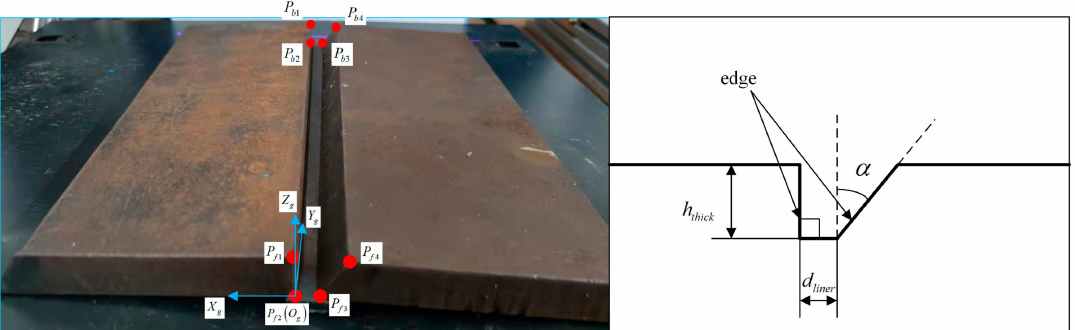
Figure 10. Characteristics points and parameters of the test steel plate. As for the selected groove, the thickness of the test steel-plate is represented by h thick , and the width of the button face is represented by d liner ; the left edge is vertical, and the right edge forms an angle of α degrees. h thick is 20 mm, d liner is 6 mm and α is 40 ◦ . The blue arrows and red circles are groove co-ordinate system and characteristics points represented in Figure